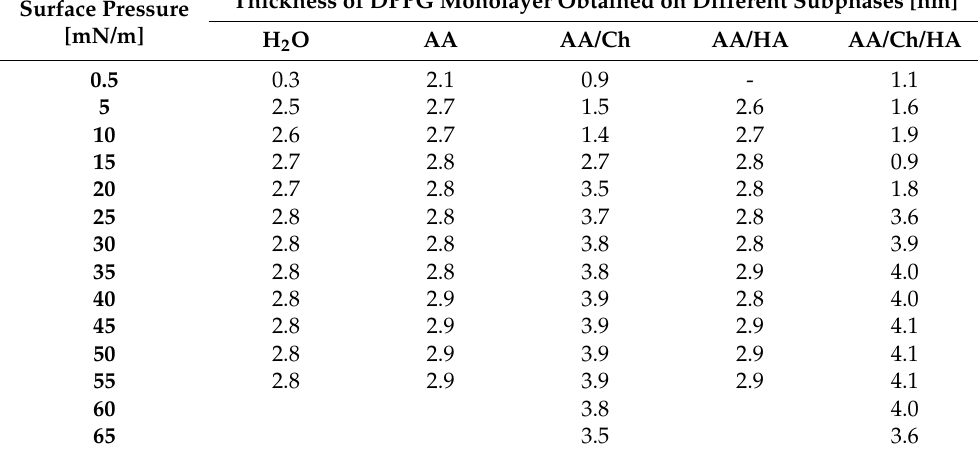
Table 2. Thickness of the DPPG monolayers during